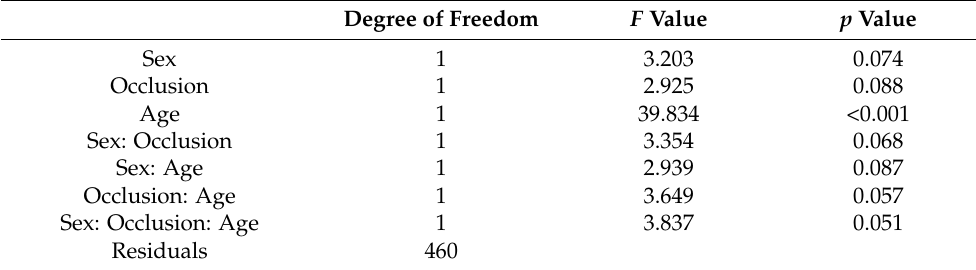
Figure 2. Maximum tongue pressure for each type of occlusion. ( a ): 4-year-old children, ( b ) 5-year-old children, ( c ) 6-year-old children. N; normal occlusion, E; excessive overjet, D; deep overbite, AO; anterior open bite, AC; anterior crossbite, C; crowding. Table 3. Results of the two-way ANCOVA.